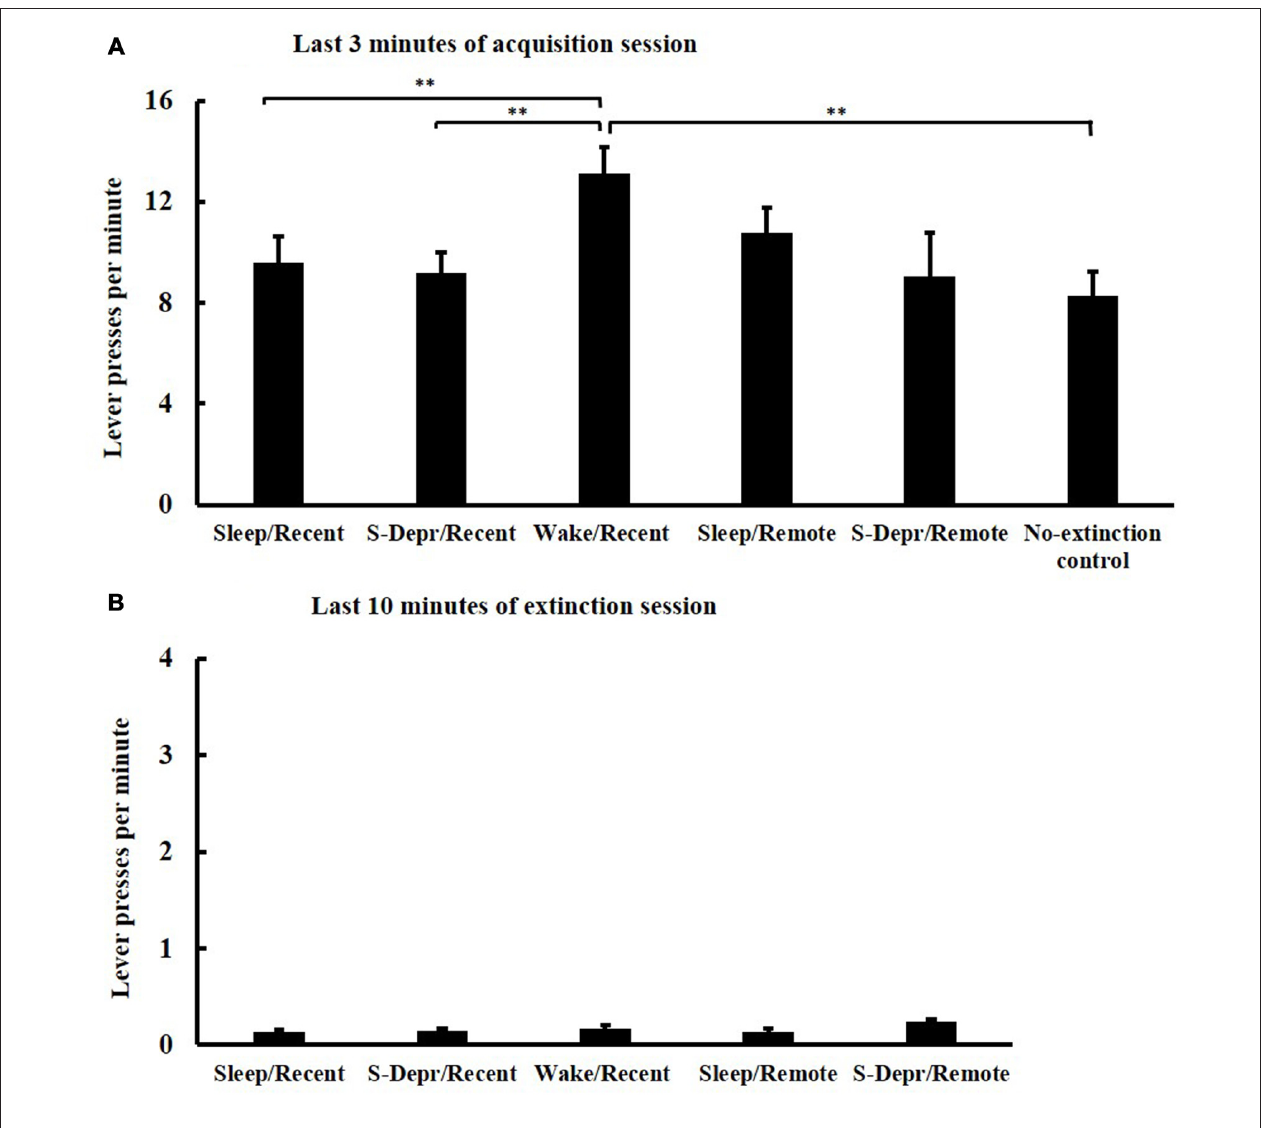
FIGURE 2 | Mean ( ± SEM) lever presses per minute (A) at the last 3-min block of the acquisition session and (B) at the last 10 min of the extinction training, separately for the Sleep/Recent, S-Depr/Recent, Wake/Recent and Sleep/Remote, S-Depr/Remote and No-extinction control groups. The No-extinction control did not undergo extinction. Significance is indicated for post hoc pairwise comparisons, ∗∗ p <